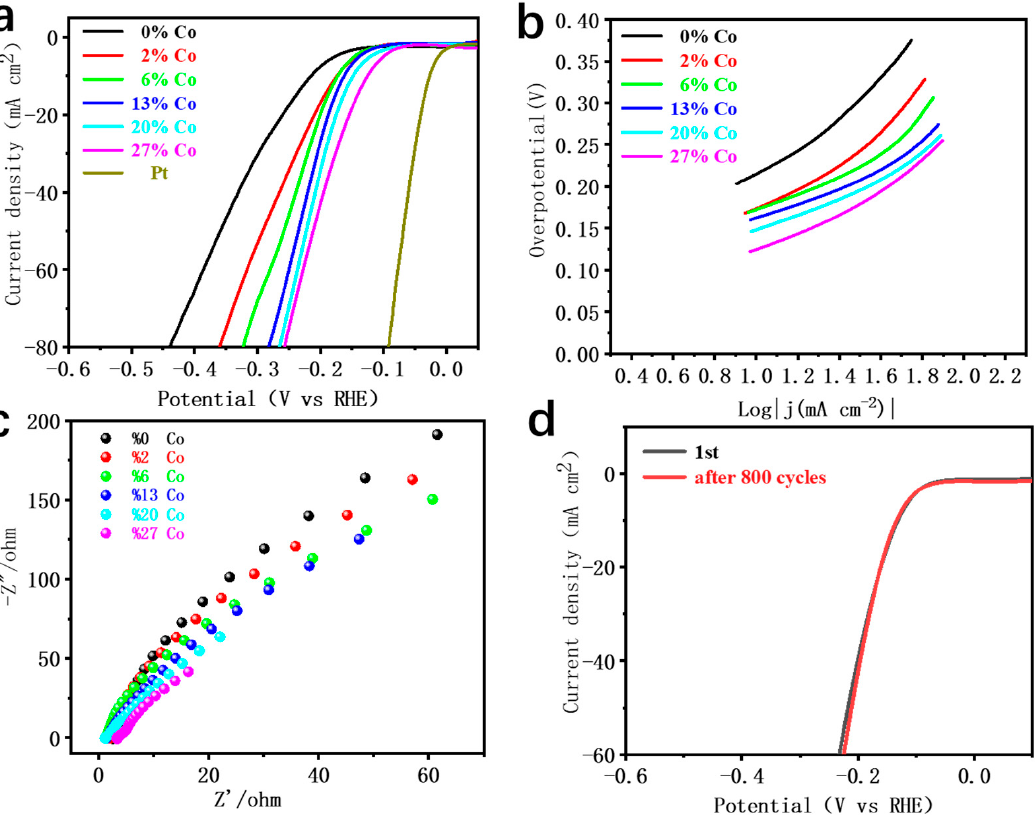
Figure 4. ( a ) LSV curves of Co-NiS 2 /CoS 2 heterostructures with different Co doping concentrations in H 2 SO 4 solution; ( b ) Tafel curves of Co-NiS 2 /CoS 2 heterostructures with different Co doping concentrations in H 2 SO 4 solution; ( c ) electro- chemical impedance spectroscopy of samples; ( d ) LSV curves before and after 800 CV